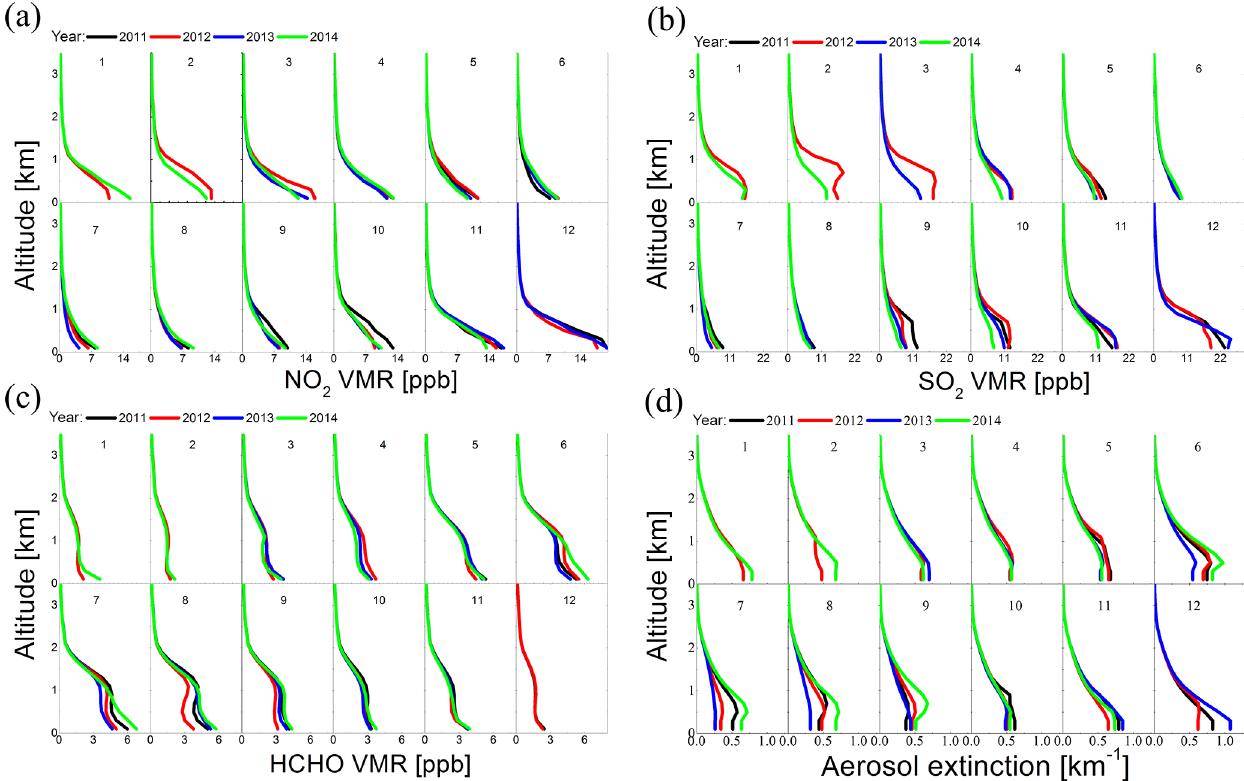
Figure 13. Monthly mean profiles of NO 2 (a) , SO 2 (b) , HCHO (c) , VMRs (under clear- and cloudy-sky conditions except for thick clouds and fog) and aerosol extinction (under clear-sky conditions) (d) for the period from May 2011 to November